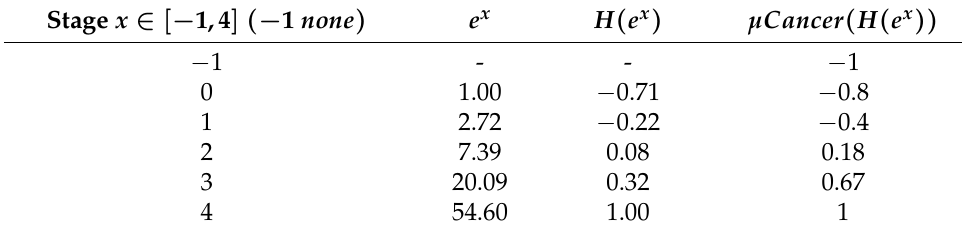
Figure 18. Fuzzy characteristic thromboembolic risk function µ ThE ( H ( x ) . Table 3. Fuzzy characteristic function table for µ Cancer ( H ( e x )) risk of